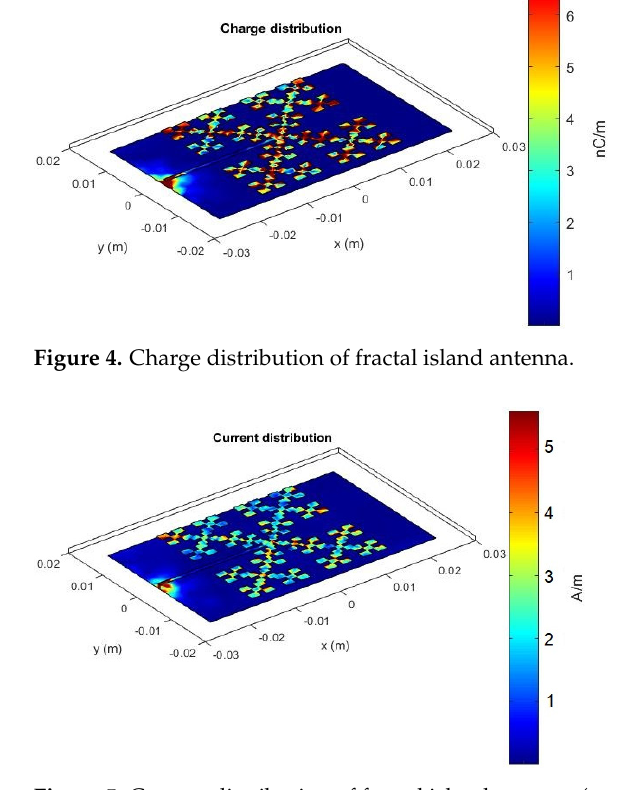
Figure 7. Current distribution of fractal island antenna (lateral alimentation). Two more interesting frequencies are discovered where the Minkowski fractal an- tenna resonates (182 GHz and 191 GHz), (WR-4). In Figures 8 and 9, current distribution simulations of fractal island antenna are made only for the resonance frequencies equal to 182 GHz and 191 GHz, respectively. Power supply/current bias to the antennas is normally made in the figure on the left, and in the figure on the right, is laterally made! Figure 8. Fractal island normal antenna at 191 GHz.